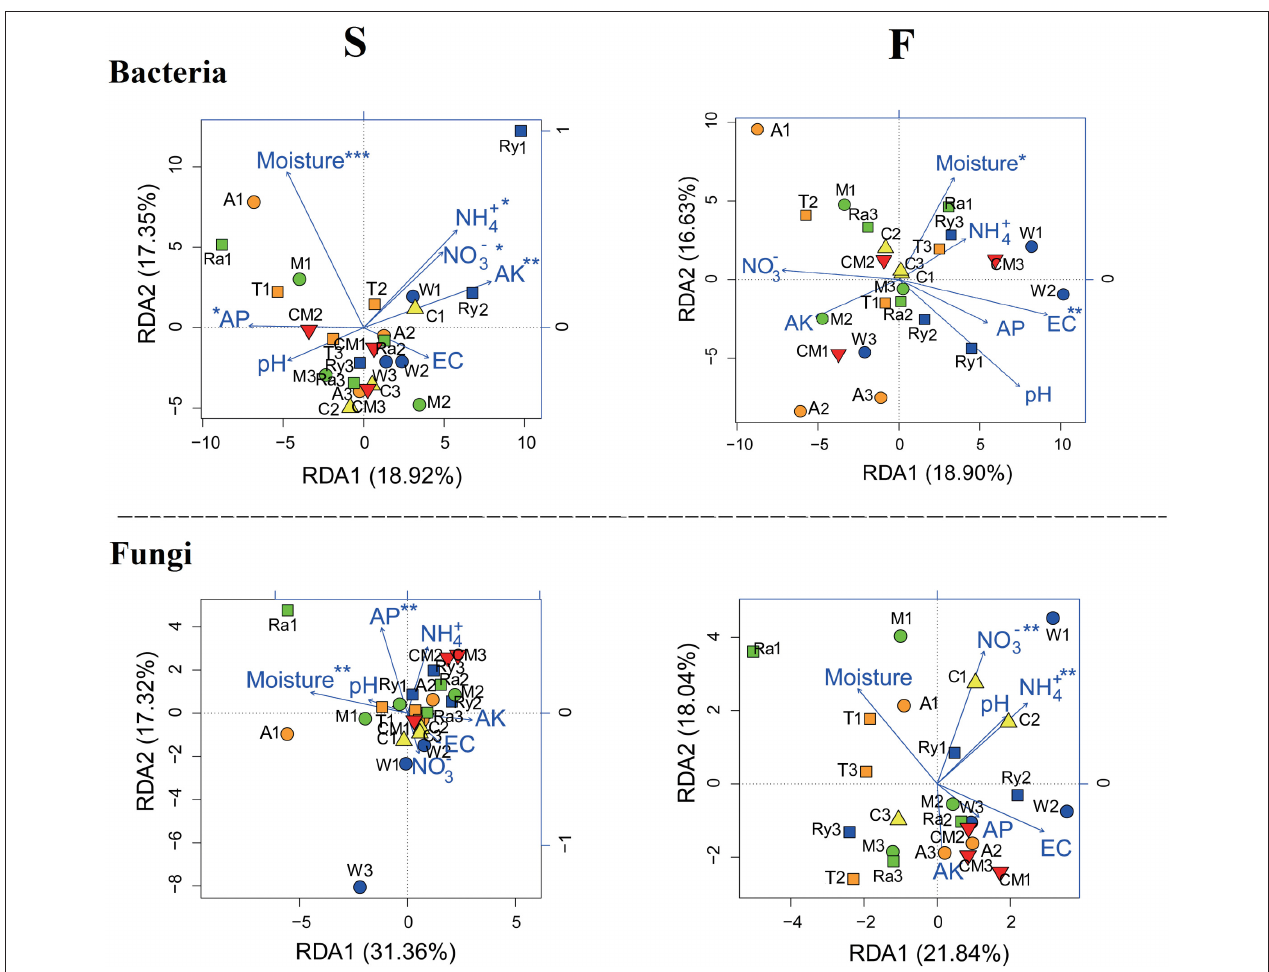
FIGURE 5 | Redundancy analysis (RDA) demonstrating the relationships between soil environmental factors and soil microbial communities during spring (S) and fall (F) cropping seasons in the control (CM), alfalfa (A), trifolium (T), wheat (W), chrysanthemum (C), rye (Ry), mustard (M), and rape (Ra). * P < 0.05, ** P < 0.01, *** P <